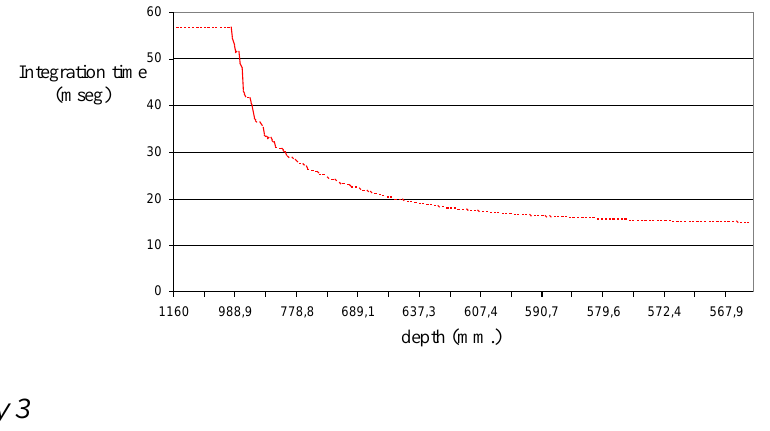
Figure 14. Integration time values at each iteration of the visual servoing task. Experiment